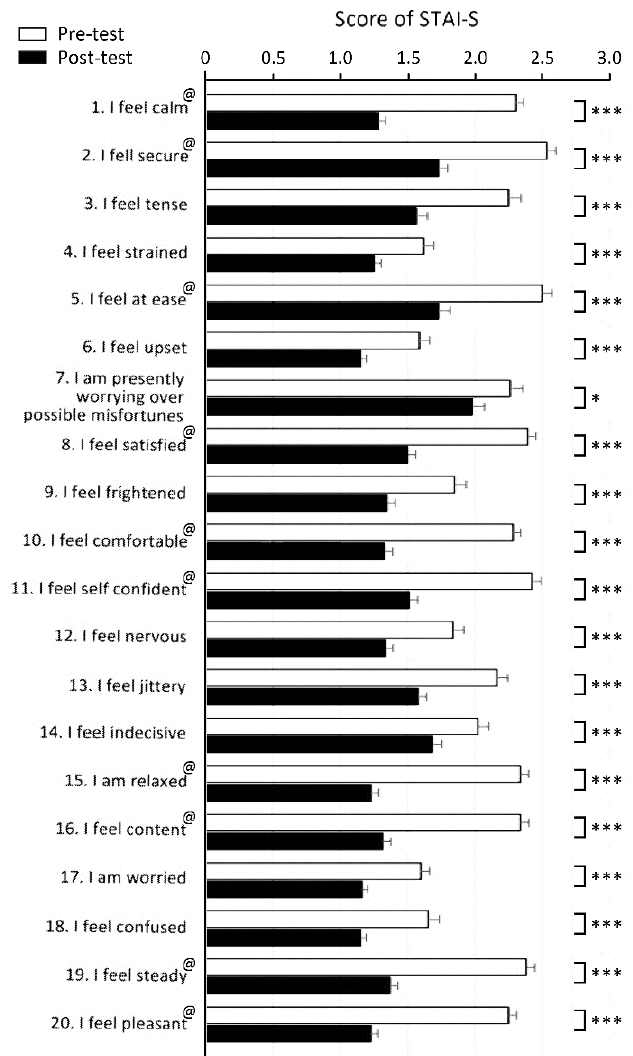
Figure 4. STAI-S scores before and after the horticultural activity and diffusion of EOs. In all questions, the scores decreased dramatically in the post-test STAI-S questionnaire. @ indicates a positive question. Data were collected from 92 participants and presented as mean ± SE. *, p < 0.05; ***, p < 0.001, Wilcoxon signed-rank test.